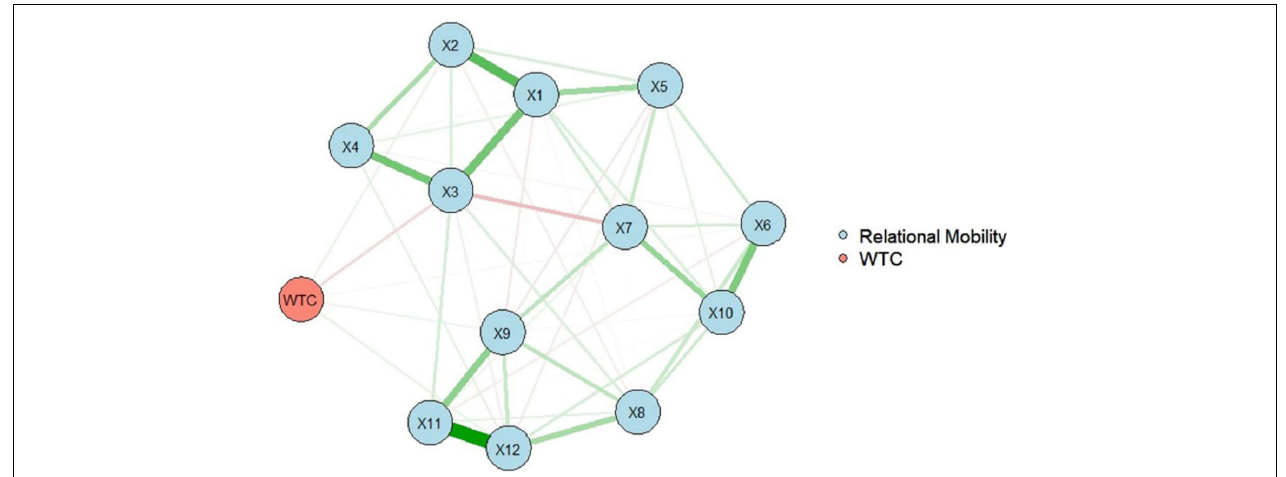
FIGURE 2 | The network structure of relational mobility and WTC in English. Nodes represent observed variables, and links represent partial correlations between two variables, after controlling for all other variables. Node numbers correspond to the variable numbers in “Materials and Methods” section.